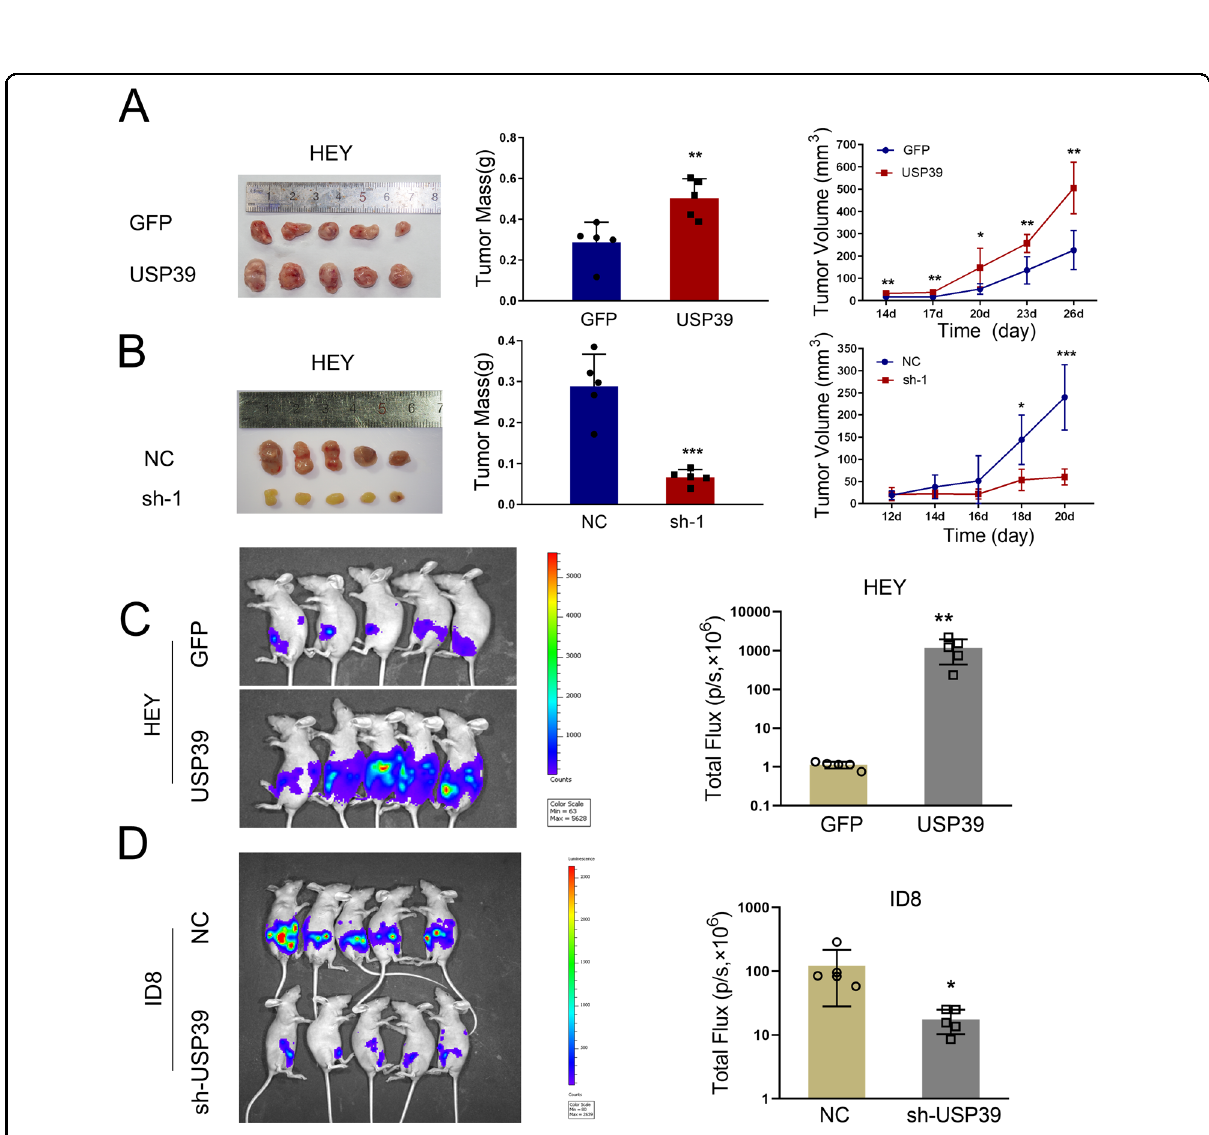
Fig. 3 USP39 promotes tumorigenesis and progression of ovarian cancer in nude mice xenografts. A , B Images of xenograft tumors, tumor mass, and tumor volume in mice subcutaneously injected with HEY cells with USP39 ( A ) overexpression (USP39) or ( B ) knockdown (sh-USP39) compared to corresponding control ( n = 5 mice per group). C , D Representative images of luciferase signals and quanti fi cation of photon fl ux in immunode fi cient mice 4 weeks after intraperitoneal injection of luciferase-expressing ( C ) HEY and ( D ) ID8 cells with USP39 overexpression and knock down, respectively ( n = 5 mice per group). P value was obtained by Student ’ s t -test. Results represent the mean ± SD. * P < 0.05, ** P < 0.01, *** P <